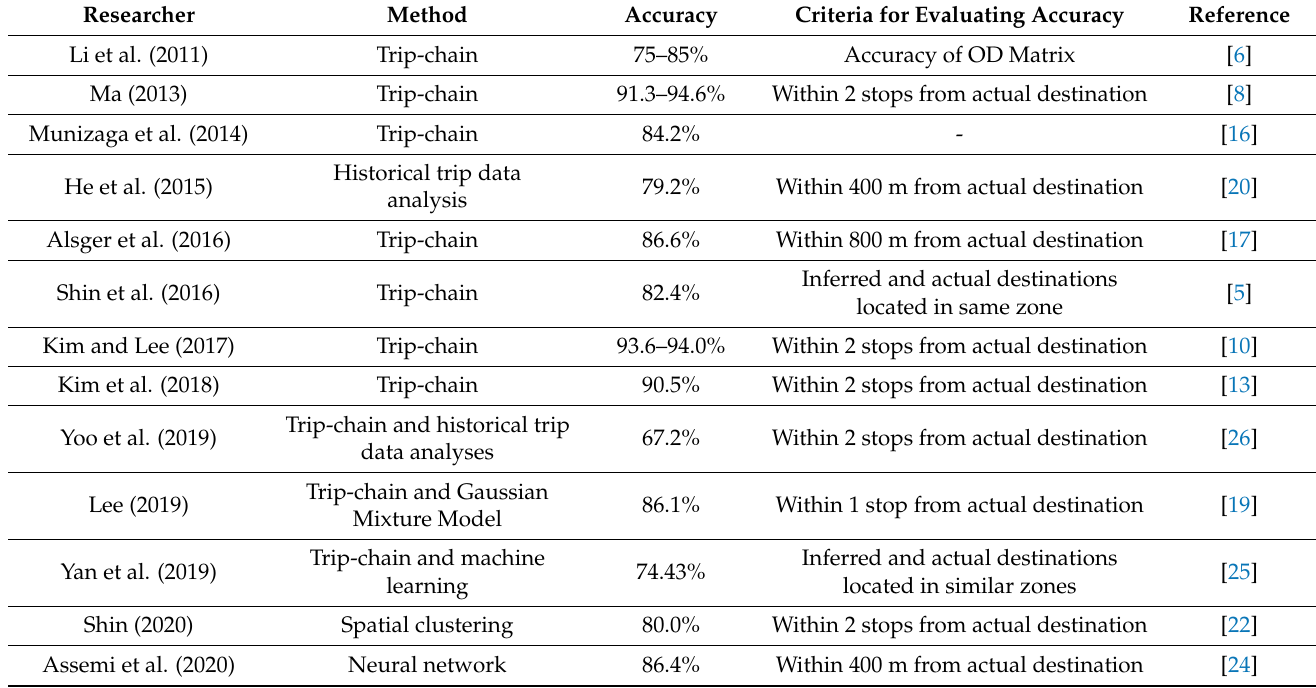
Table 1. Accuracy of destination inference results from previous